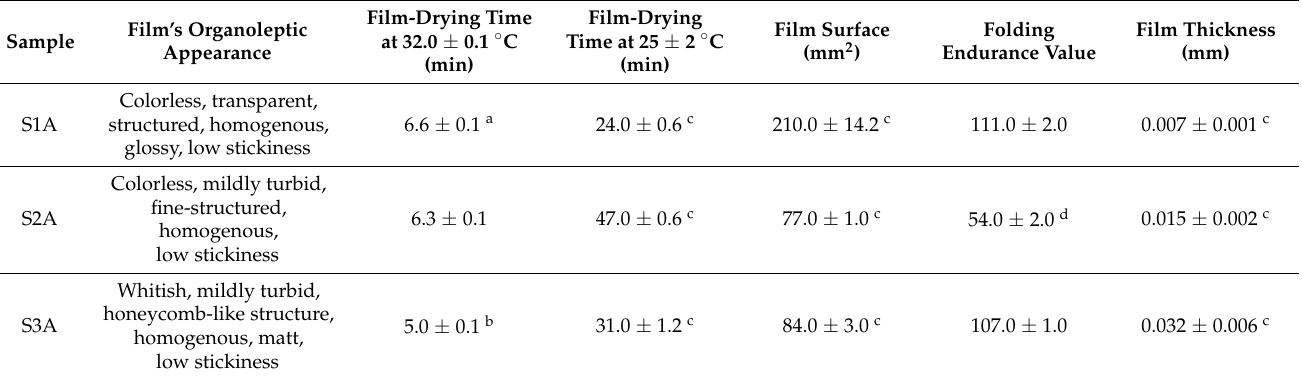
Table 3. Physicomechanical evaluation of the BDP-loaded film-forming systems (mean ± SD, n = 3).